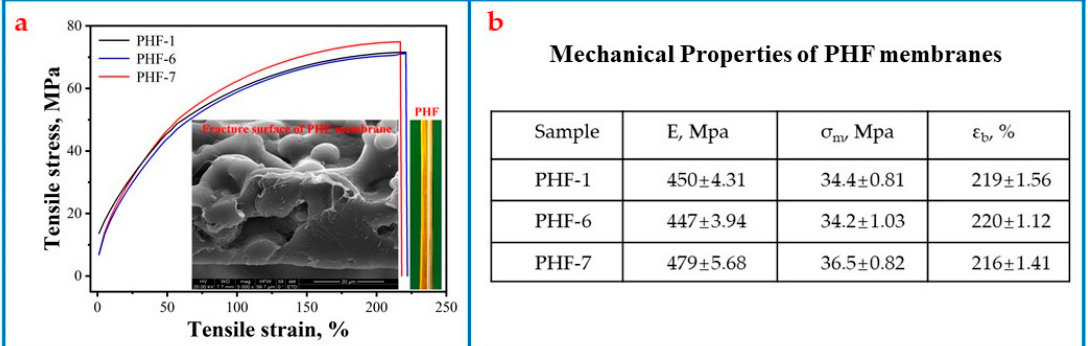
Figure 5. The mechanical properties of PHF membranes.